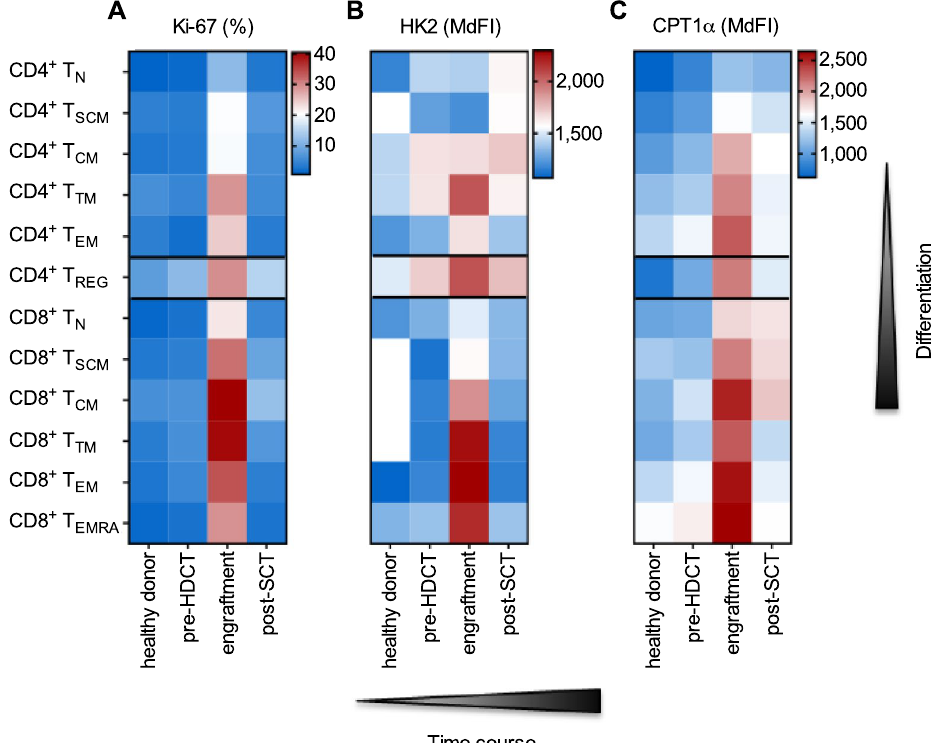
Figure 6. CD4 + and CD8 + T-cells at early differentiation stages were less proliferative and less metabolically active. ( A ) Proliferation of CD4 + and CD8 + T-cell differentiation stages including naïve (N), stem cell memory (SCM), central memory (CM), transitional memory (TM), effector memory (EM), effector memory CD45RA + (EMRA) and regulatory T-cells (REG) was evaluated by color-coding the percentages of Ki-67 + cells. ( B ) The glycolytic pathway was analyzed by measuring HK2 expression. ( C ) The FAO pathway was analyzed by measuring CPT1α expression. All results of the latter two markers were color-coded based on the median fluorescence intensity (MdFI) for all cell populations (n: 10; mean values). The mean of a healthy donor control group (n: 10) was included for